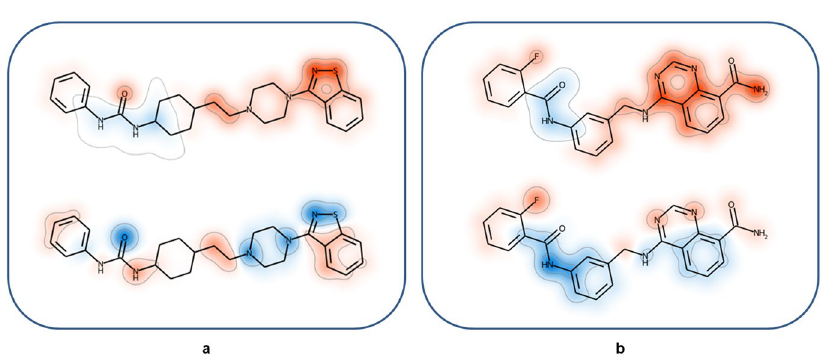
Figure 3. Feature weight mapping. Shown are SVM weights of individual features mapped to corresponding atoms. A Gaussian function proportional to the atom weight was placed on each atom position. The resulting height profile was visualized using a red color gradient for positive values, i.e., weights associated with DT activity (responsible for correct predictions), and a blue color gradient for negative values (weights associated with ST activity; incorrect predictions). ( a ) Depicted is a DT-CPD active against the 5-hydroxytryptamine receptor 1A and dopamine D2 receptor. At the top and bottom, feature contributions from the native classifier and a model derived for another target pair (glucocorticoid receptor, progesterone receptor) are depicted, respectively. ( b ) A DT-CPD with activity against Aurora kinase A and B is shown. At the top and bottom, feature contributions from the native classifier and a model derived for a different target pair (ocxytocin receptor, vasopressin V1a receptor) are